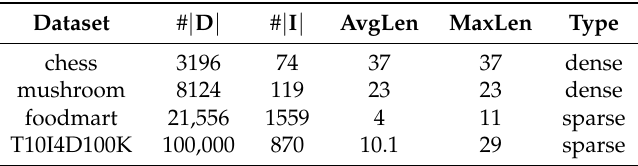
Table 5. Characteristics of datasets